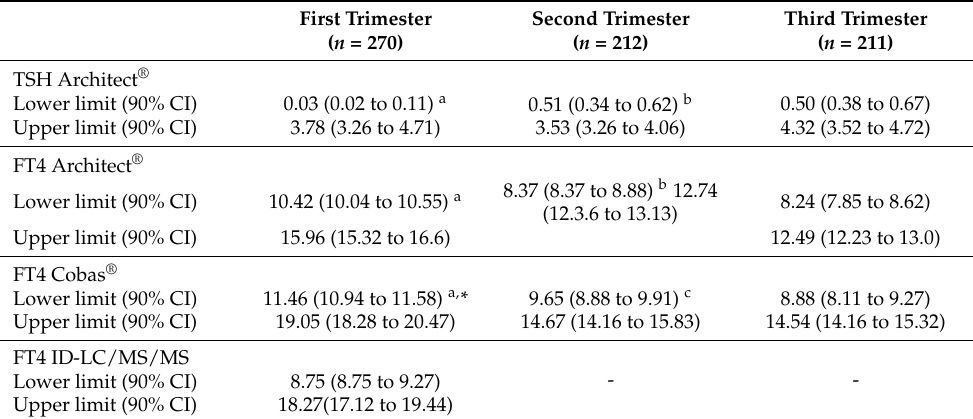
Table 2. The 95% reference interval, double-sided, determined by the non-parametric percentile method (CLSI C28-A3) for thyrotropin and free thyroxine in the 3 trimesters of pregnancy, mea- sured by immunoassays, and free thyroxine, measured by liquid chromatography/tandem mass spectrometry (in the first